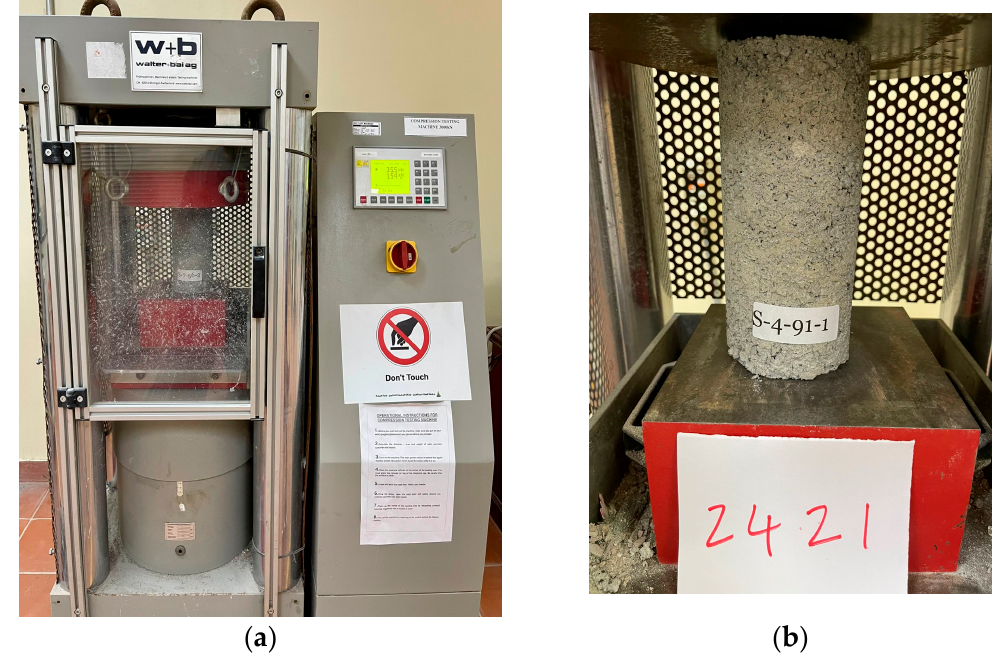
Figure 5. ( a ) Uniaxial compression machine with ( b ) a concrete sample in the testing position.